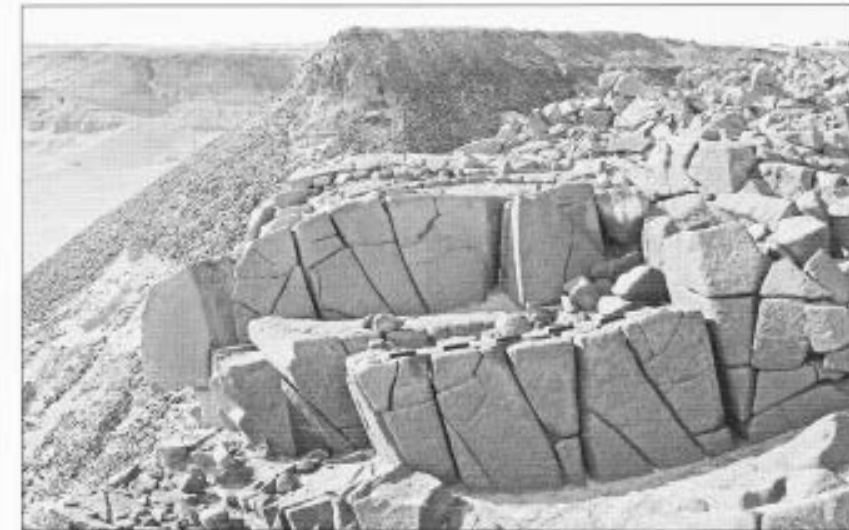
Figure 5 Old Kingdom basalt quarry at the edge of the escarpment, Widan el-Faras.